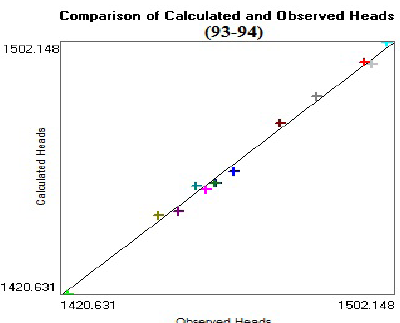
Figure 5. Observed and estimated heads in 2015